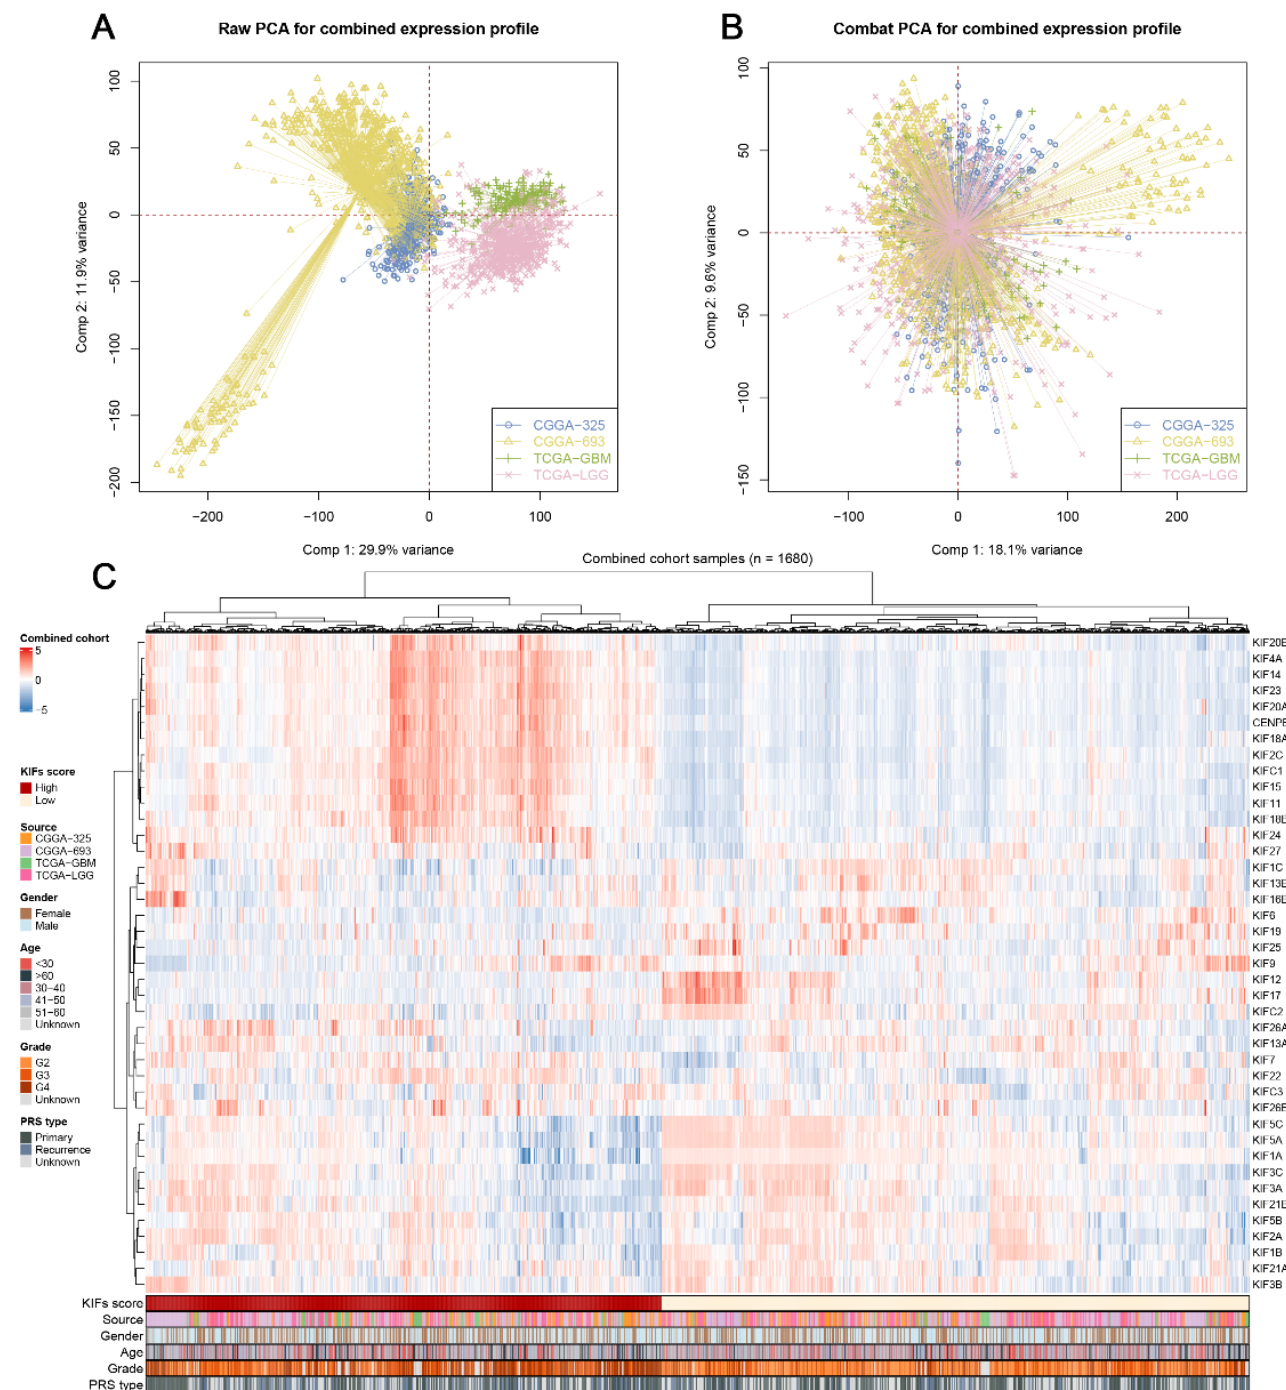
Figure 1. Combination of glioma cohort and expression of KIFs. Notes: ( A ) Four glioma cohorts selected for our analysis have noticeable batch differences; ( B ) the sva package used for glioma cohort combination greatly reduces the batch difference; ( C ) expression profile of KIFs in all patients.